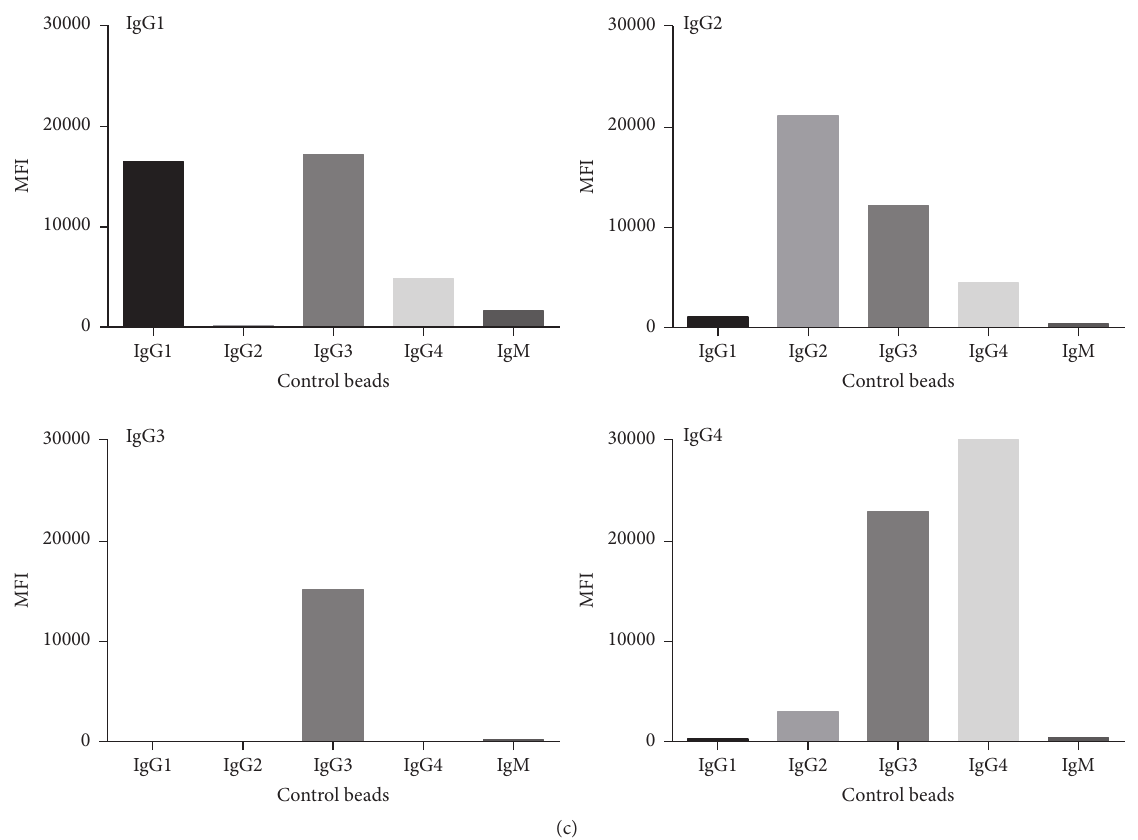
Figure 3: Examples of serum-dependent cross-reactivity of IgG subclass detection on control beads. The control beads were incubated with different patient sera, washed, and then detected with subclass-specific secondary antibodies ((a): patient serum 1; (b): patient serum 2; (c): patient serum 3).